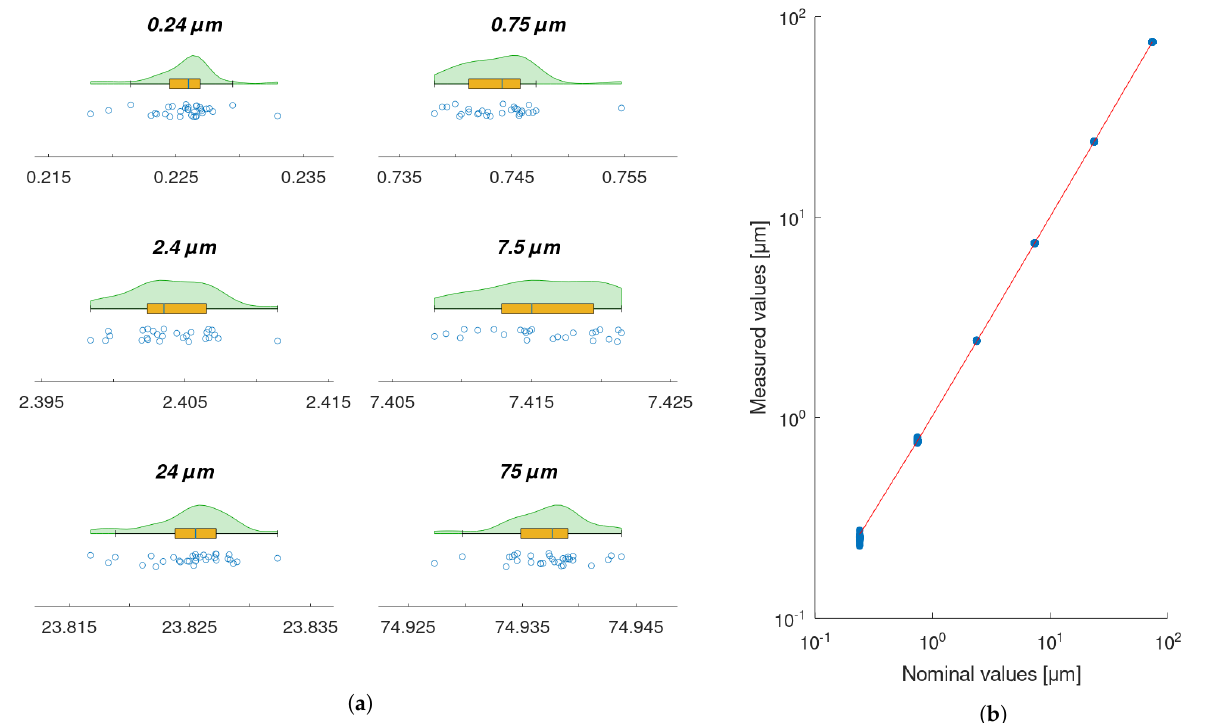
Figure 10. ( a ) Raincloud plots for each piezo-actuator displacement being measured with Taylor Hobson 130; ( b ) Scatterplot of data points representing the relationship between the piezo actuator displacement (estimated based on the required displacement and the calibration linear model obtained with the XL-80 interferometer) and the displacement being measured with the Taylor Hobson 130. The quadratic regression model is fitted (1 − R 2 = 3.1 × 10 − 7